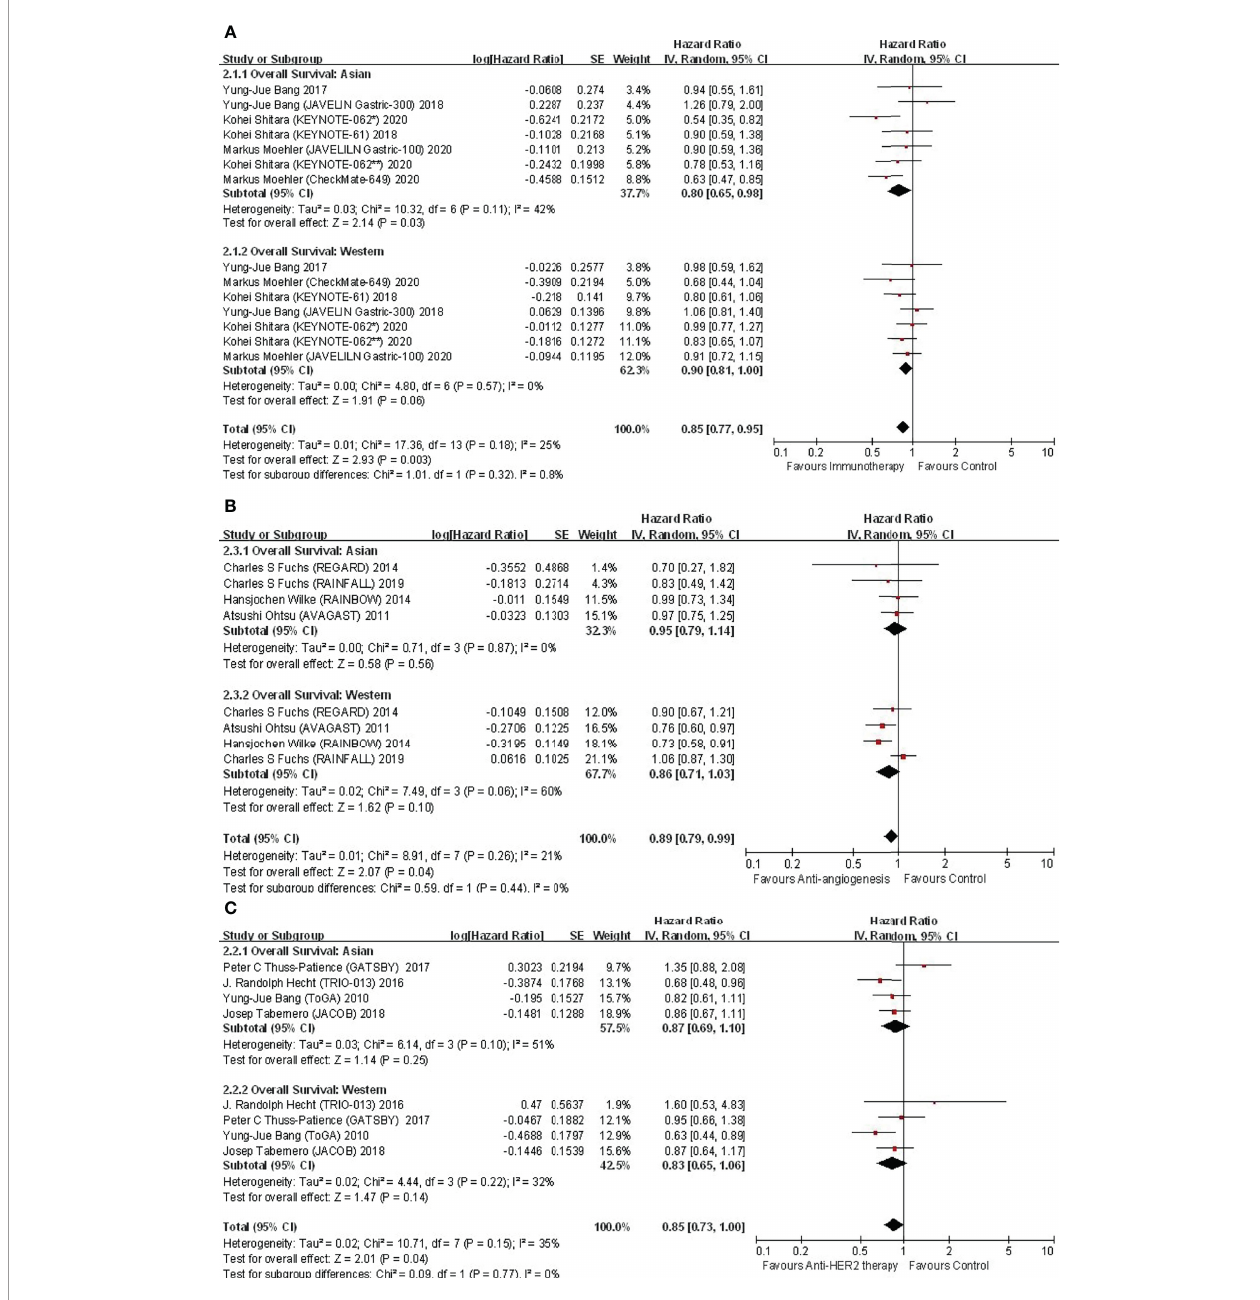
FIGURE 2 | Comparison of regional subgroup differences in OS bene fi t with (A) immunotherapy; (B) anti-angiogenic therapy; and (C) anti-HER2